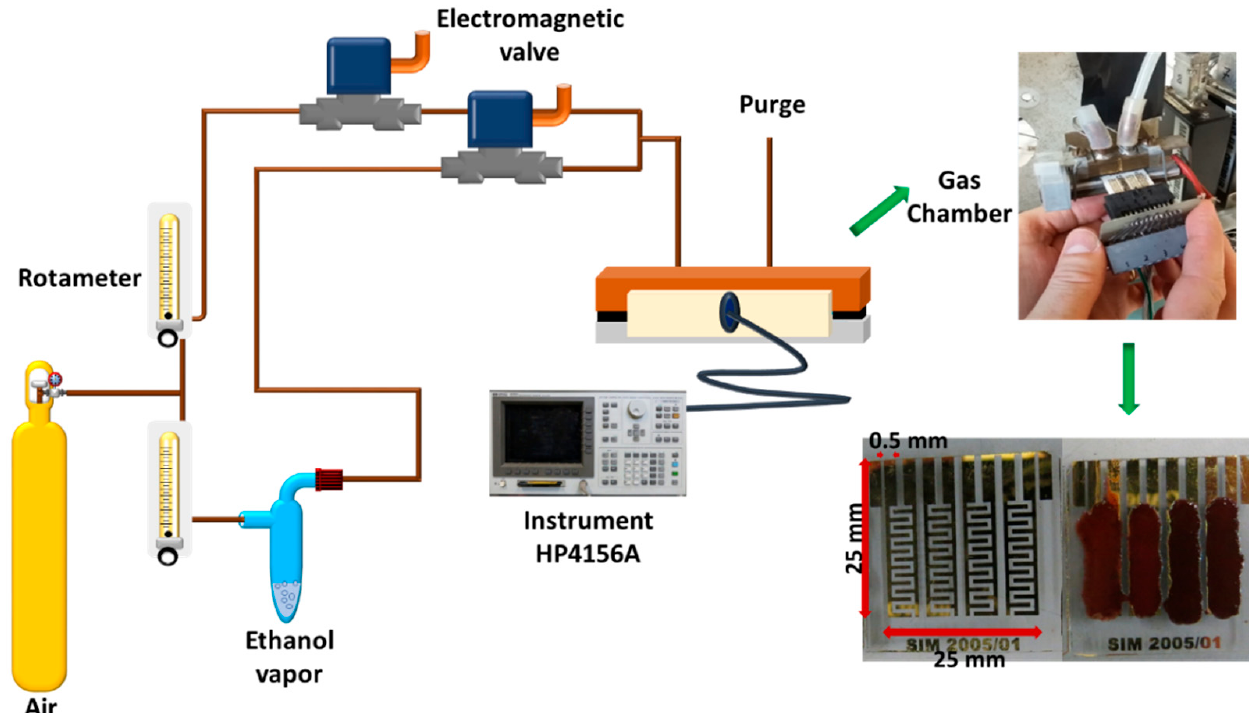
Figure 1. Delivery system of gases to the gas chamber with prepared sensors.